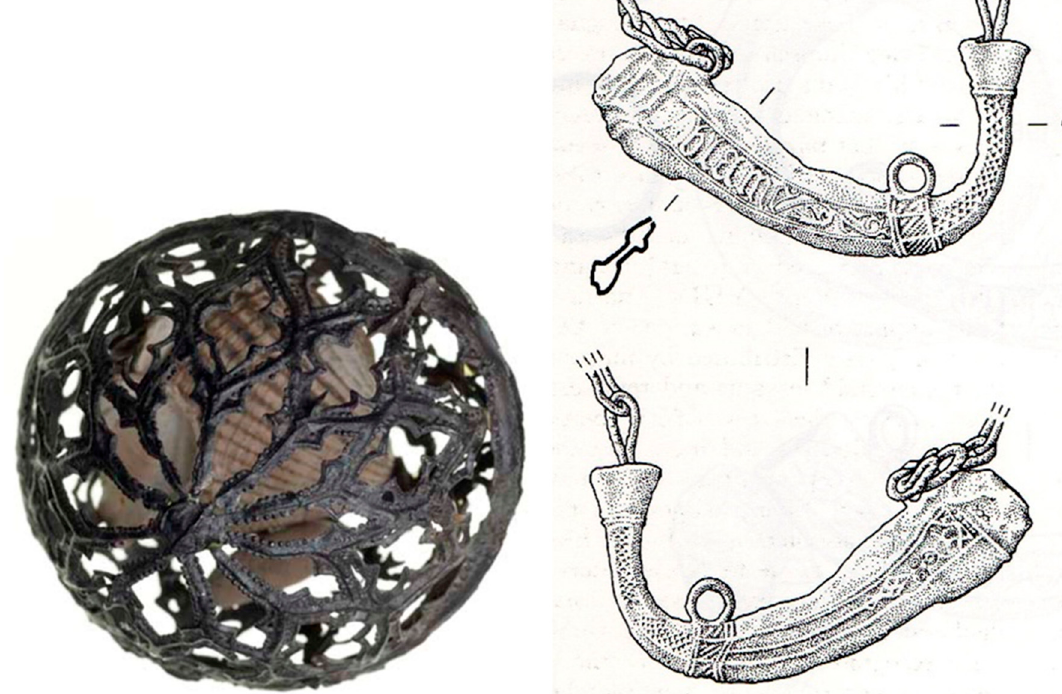
Figure 12. ( left ) Rattle with shells, 14th century, Museum of London, Photo: Museum of London. ( right ) Secular whistle, 15th century, Salisbury Museum of Art. Photo: After Spencer, Pilgrim Souvenirs … Salisbury , pp. 63–64, cat. No. 196.